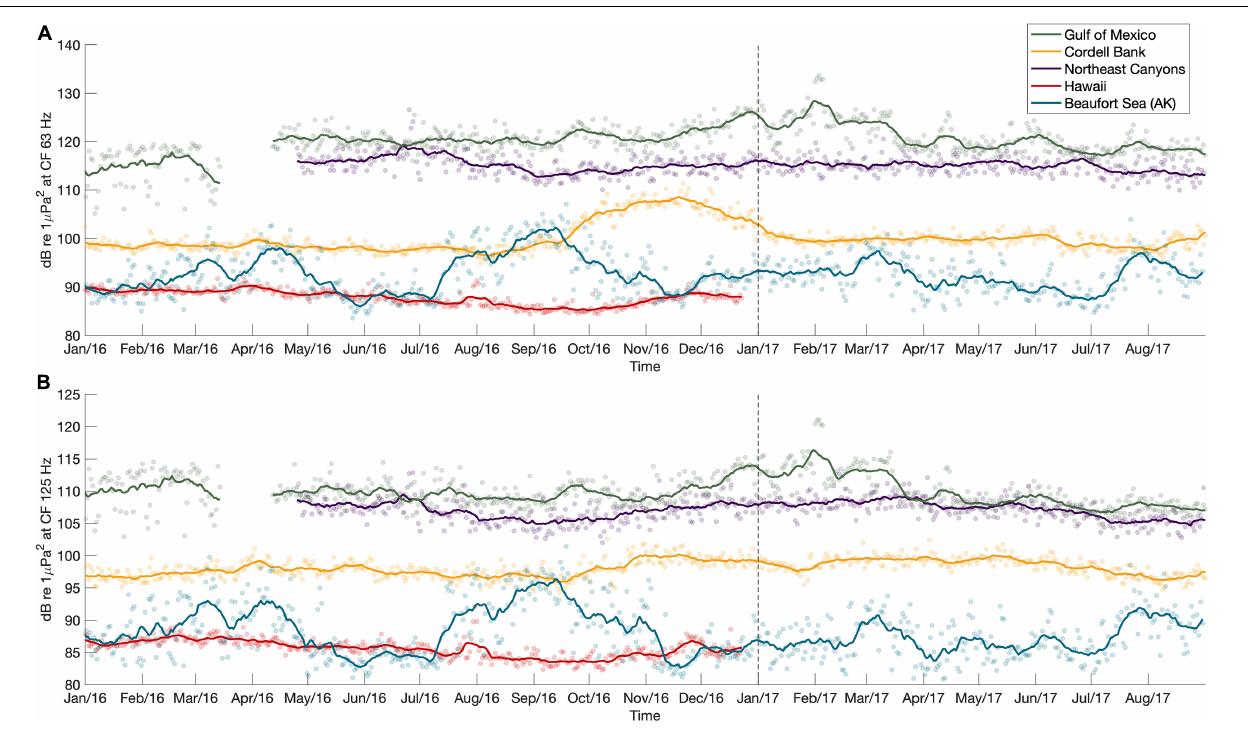
FIGURE 2 | Daily one-third octave band sound pressure level measurements for 63 Hz (A) and 125 Hz (B) center frequencies (scatter plot) and overlaid 14-day moving average for five deep-water autonomous underwater hydrophone moorings from January 2016 through August 2017. Each mooring site is color-coded: Gulf of Mexico-green, Cordell Bank National Marine Sanctuary-yellow, Northeast Canyons and Seamounts National Monument-purple, Hawaii-red, Beaufort Sea Alaskan Arctic-blue.